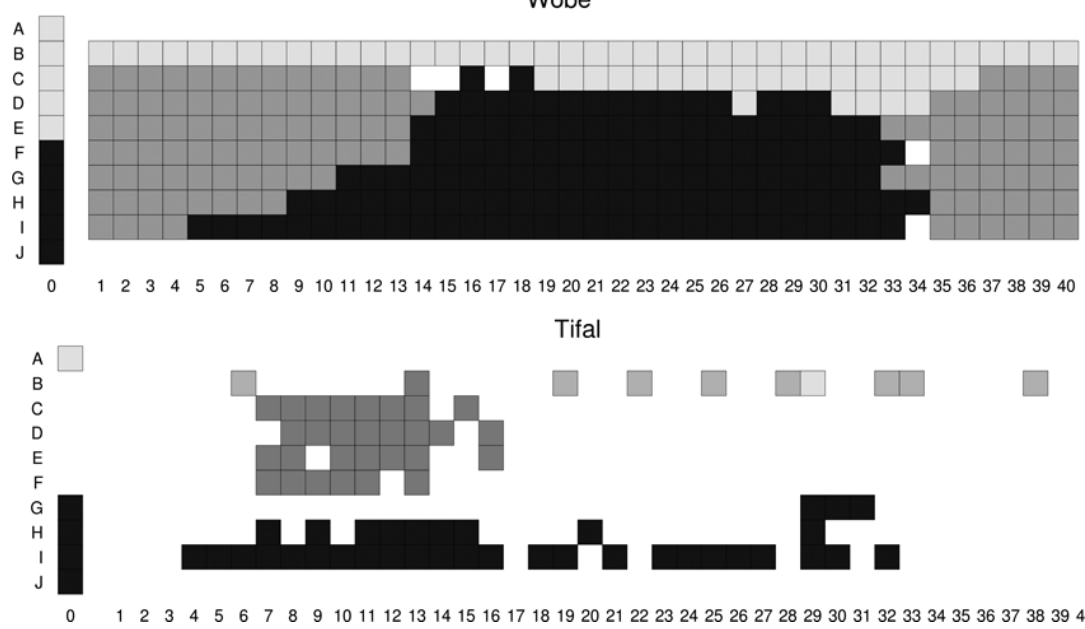
Figure 2: Two examples of majority maps. Plots are created using the ‘ggplot2’ R package. Coloring is done automatically and in grey scale to avoid inadvertent connotations of native color terms to English